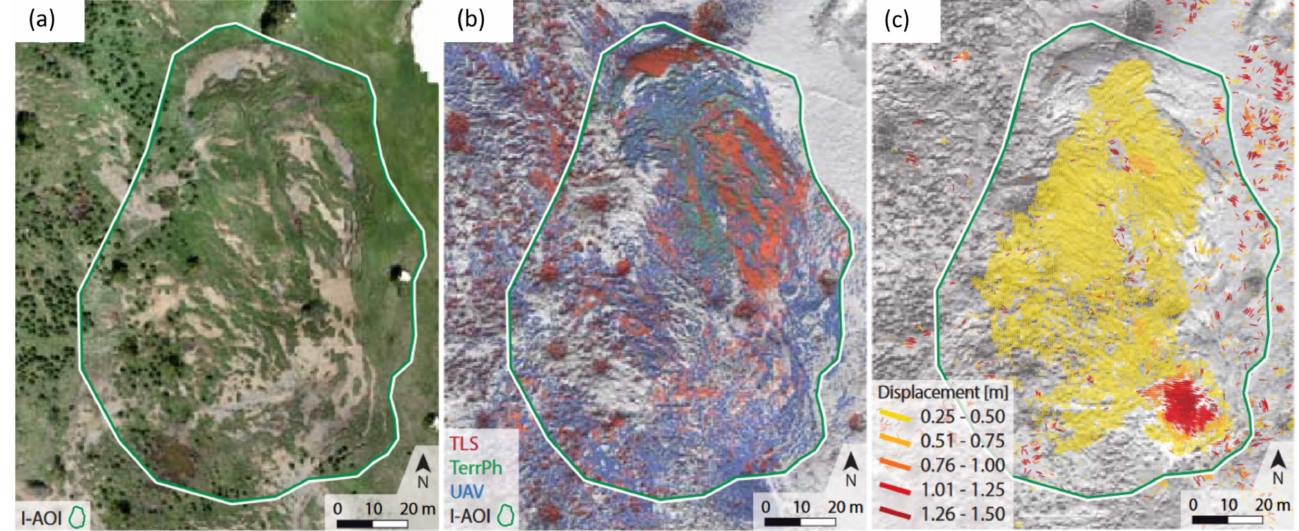
Figure 10. Example of photogram cloud points integration technique to retrieve ground surface deformation. UAV-based orthophotograph ( a ), dense image matching integrating UAV, TLS and terrestrial photogrammetry ( b ), and Displacement vectors greater than 0.25 m between 2016 and 2017 resulting from image correlation of the shaded reliefs ‘minimum elevation’ rule ( c ) Example of an active area of the Corvara landslide (adopted with permission from